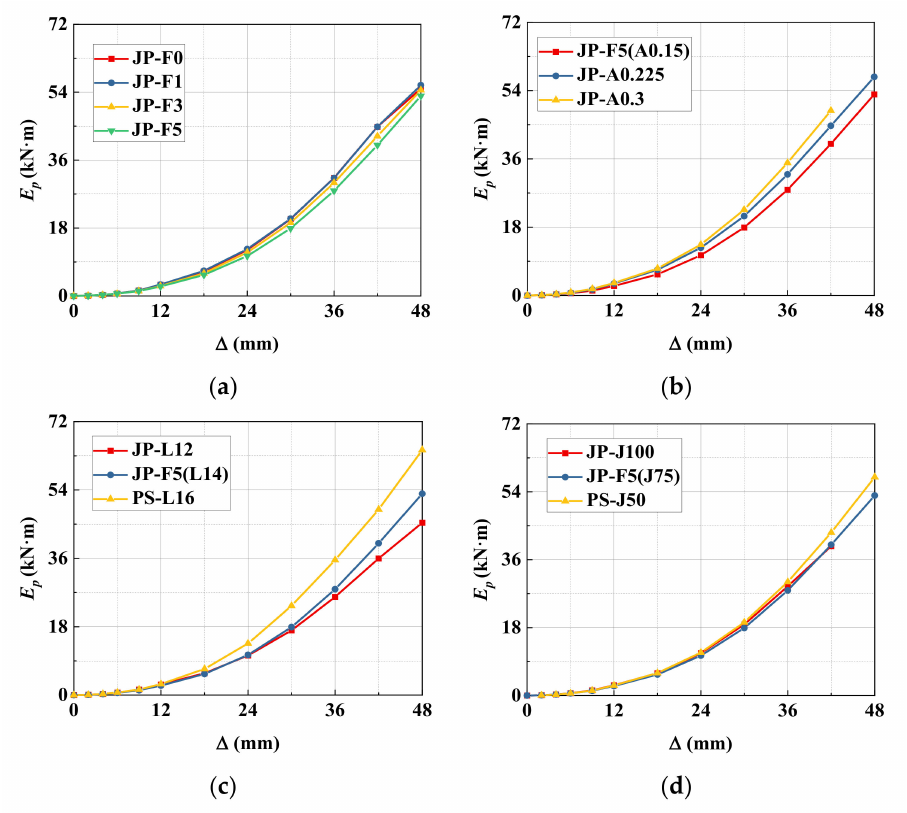
Figure 33. Cumulative energy dissipation. ( a ) The number of freeze–thaw cycles. ( b ) The ratio of axial compression. ( c ) Diameter of longitudinal reinforcement. ( d ) Stirrup